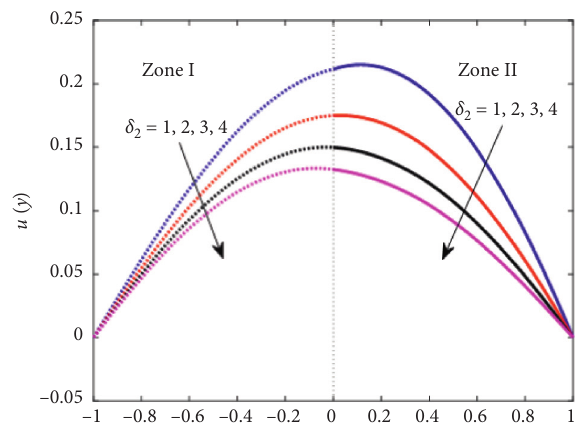
Figure 4: Velocity profiles for various δ